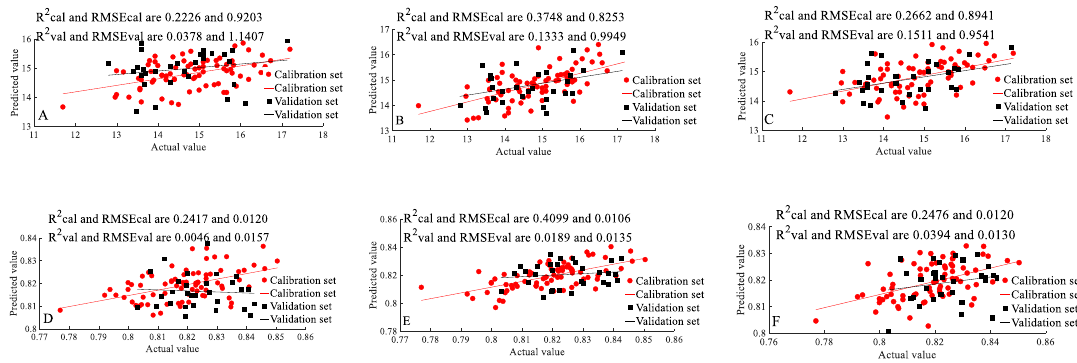
Figure 3. TSSC and water content detection based on machine vision data from the ( A , D ) stem side position, ( B , E ) equator position, ( C , F ) blossom side position; ( A – C ) TSSC detection, ( D – F ) water content detection.